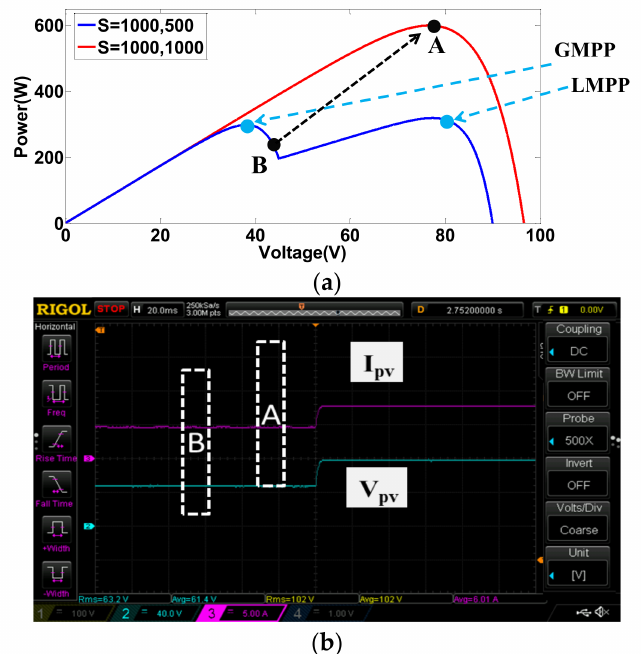
Figure 17. Results of transition from shading condition (B) to normal condition (A): ( a ) simulation; ( b ) implementation.